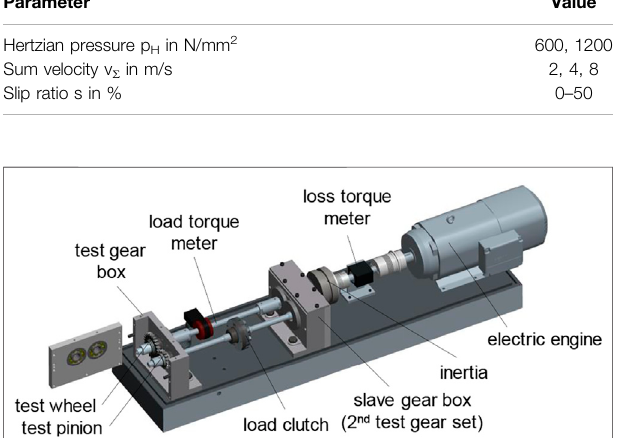
FIGURE 4 | Mechanical layout of the FZG gear ef fi ciency test rig (Lohner, 2016).